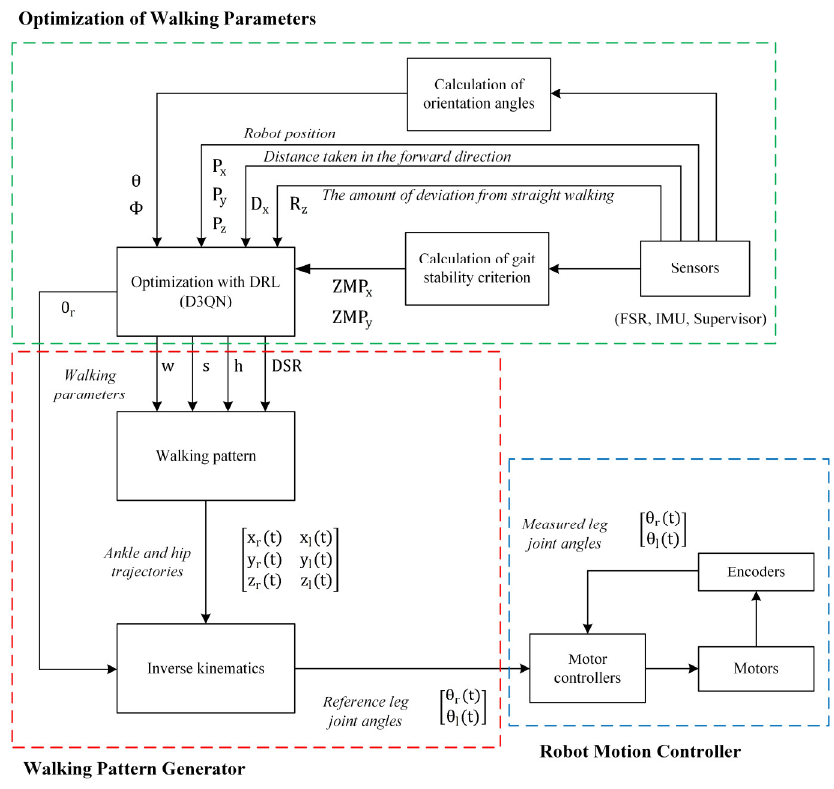
Figure 11. Proposed framework for stable walking.